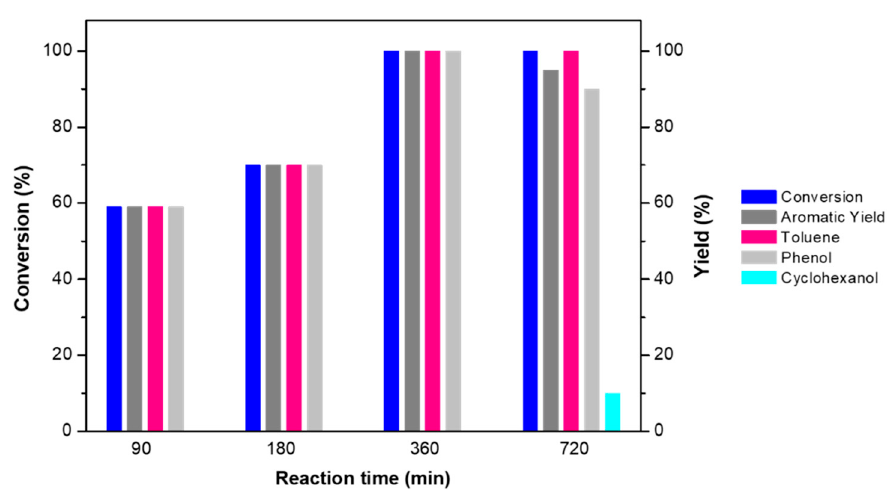
Figure 8. Reaction time effect in the CTH of BPE at 240 °C in the presence of Pd/Fe 3 O 4 [wnf] catalyst and 2-propanol as solvent/H-source (reaction conditions: 0.125 g of catalyst; 40 mL of 0.1 M BPE solution; temperature, 240 °C; N 2 pressure, 10 bar; stirring, 500 rpm).